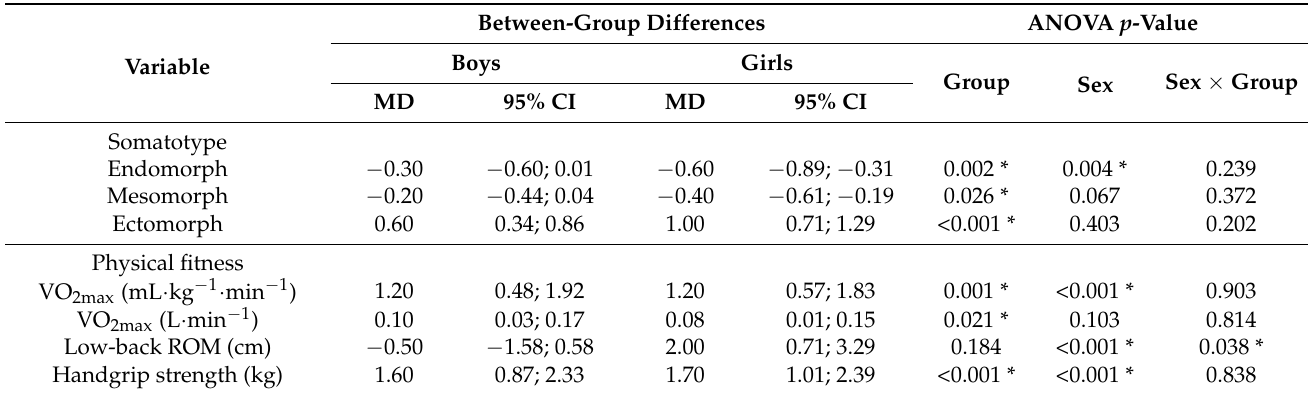
Figure 2. Somatochart of boys and girls aged 10–11 years who regularly practice table tennis against those who are physically active but not engaged in a regular activity. Error bars are stand- ard deviations.